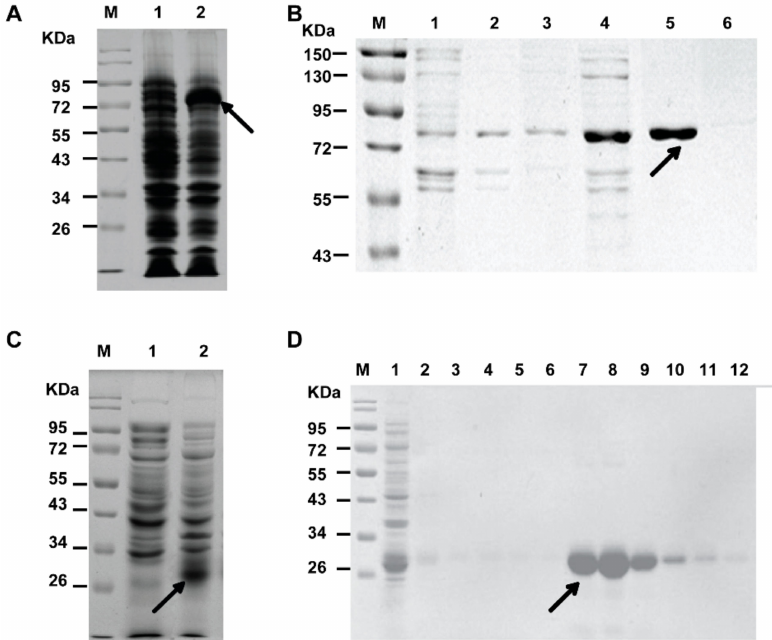
Figure 2. Expression and purification of His-PCSK9 and GST-EGF-A. ( A ) Expression of His-PCSK9 (Lane M: prestained protein marker; Lane 1: cell lysate before induction with isopropylthio- β - D -galactopyranoside (IPTG); Lane 2: cell lysate after 24 h of expression); ( B ) Purification of His-PCSK9 (Lane M: pre-stained protein marker; Lane 1–6: elution by buffer with 2 mM, 5 mM, 10 mM, 25 mM, 50 mM, and 250 mM imidazole, respectively); ( C ) Expression of GST-EGF-A (Lane M: pre-stained protein marker; Lane 1: cell lysate before induction with IPTG; Lane 2: cell lysate after 24 h of expression); ( D ) Purification of GST-EGF-A (Lane M: prestained